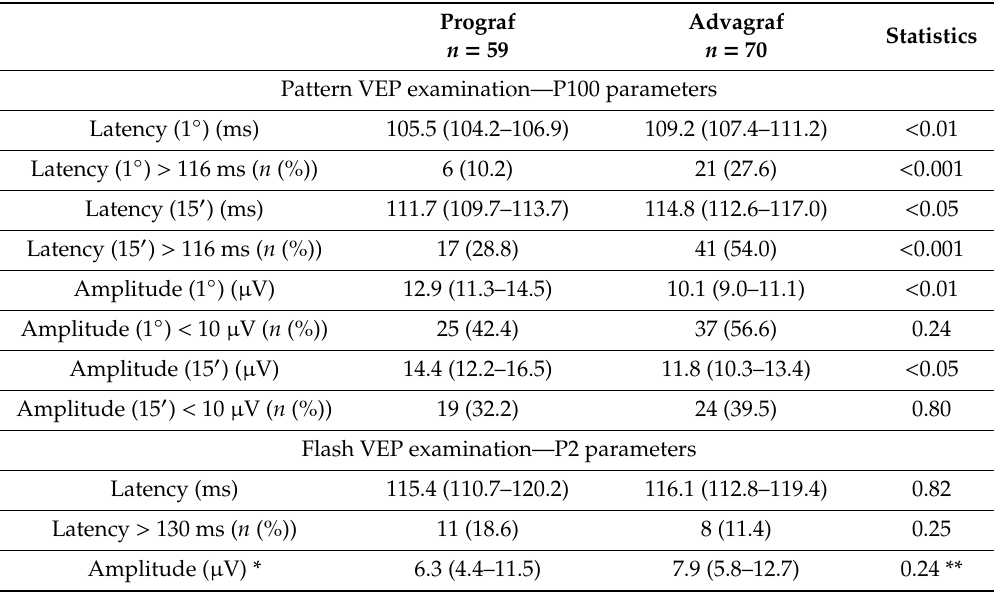
Table 2. Results of pattern and flash VEP examinations in the eyes of kidney transplant recipients treated with two di ff erent tacrolimus formulations.